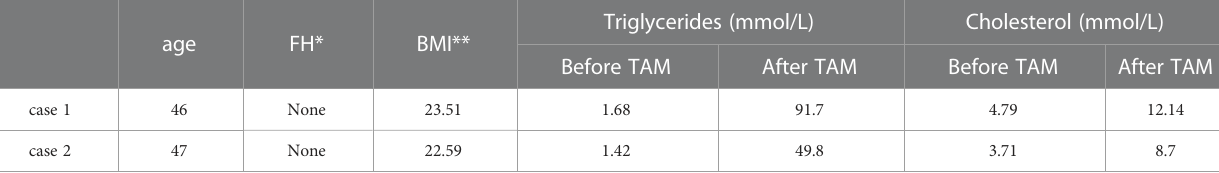
TABLE 2 The clinical and lab values about the two